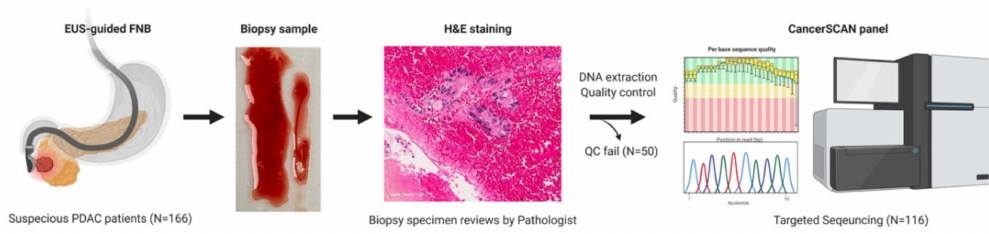
Figure 1. The schematic flow of study design. Patients suspected of PDAC (N = 166) performed endoscopic ultrasound- guided fine-needle biopsy (EUS-FNB) to obtain pancreas specimens, which were examined by pathologists after hematoxylin & eosin (H&E) staining. DNAs were extracted from each PDAC specimen, and DNA analytes (N = 116) passing a quality control (QC) test were sequenced by using CancerSCAN ® panel. PDAC, pancreatic ductal